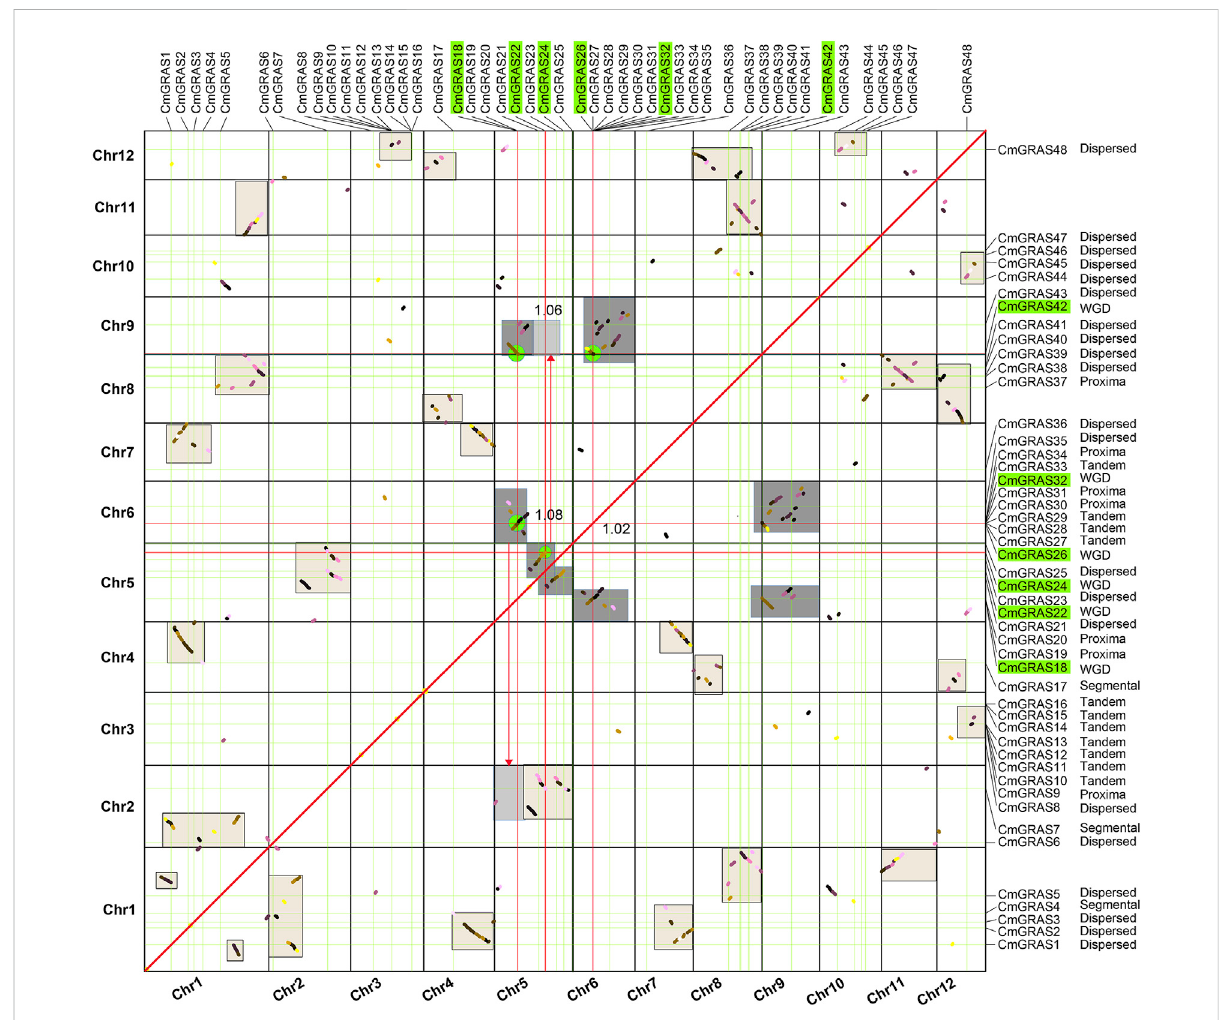
Homologous collinearity dot-plot within Chinese chestnut genome. The collinear blocks from WGD containing CmGRAS genes are marked in the gray boxes of the fi gure, and the median Ks of the collinear blocks are